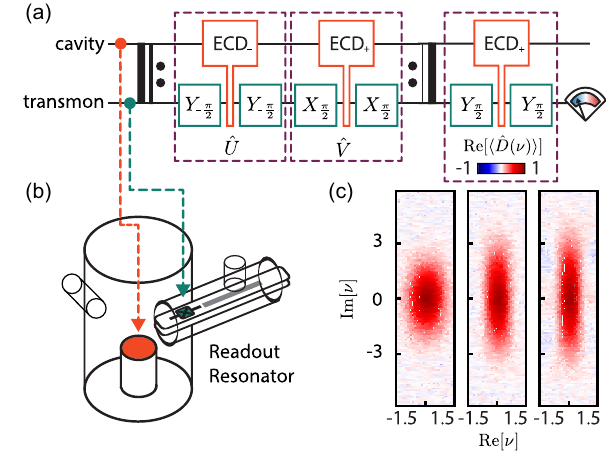
FIG. 2. Deterministic phase-space compression in cQED. (a) With vacuum as the initial state, the protocol generates ˆ V compressed vacuum states based on Ref. [72]. An additional operation followed by a single-shot readout is used to create the ˆ U ˆ V compressed cat states; see Appendix B. The and operations are each decomposed into two transmon rotations and one ECD gate. The resulting states are measured by their characteristic functions,whichareobtainedusingtheECDgate;seeAppendixC. (b) Color-coded schematic of the device showing the storage cavity, transmon, and readout mode. (c) Real part of the character- istic functions of compressed vacuum states generated by three ˆ U ˆ V repetitions of the operations with phase-space compression of − 3 , − 6 . 7 , and − 7 . 6 dB along Re ½ ν (cid:3) ,